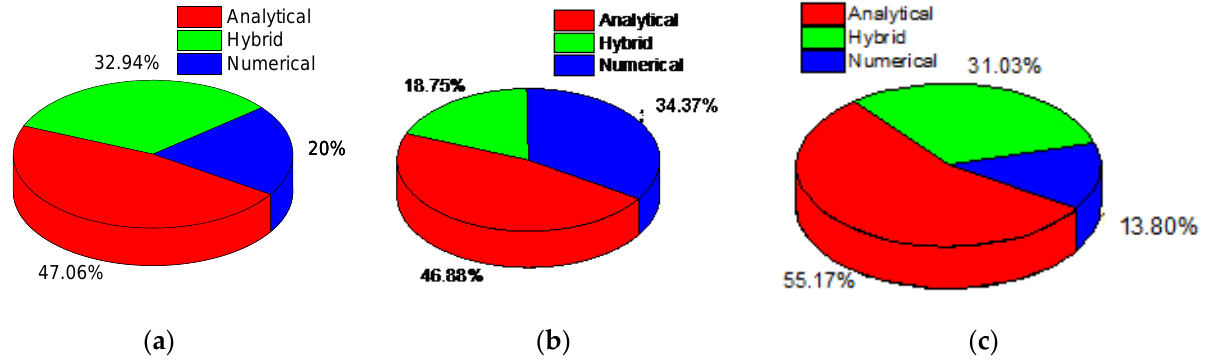
Figure 4. Different analyses employed in percentage to analyze electrokinetic flow in microchannels based on the existing literature. ( a ) Rectangular channel with electric field applied; ( b ) Non-rectangular channel with electric field applied; ( c ) Both electric and magnetic fields applied.